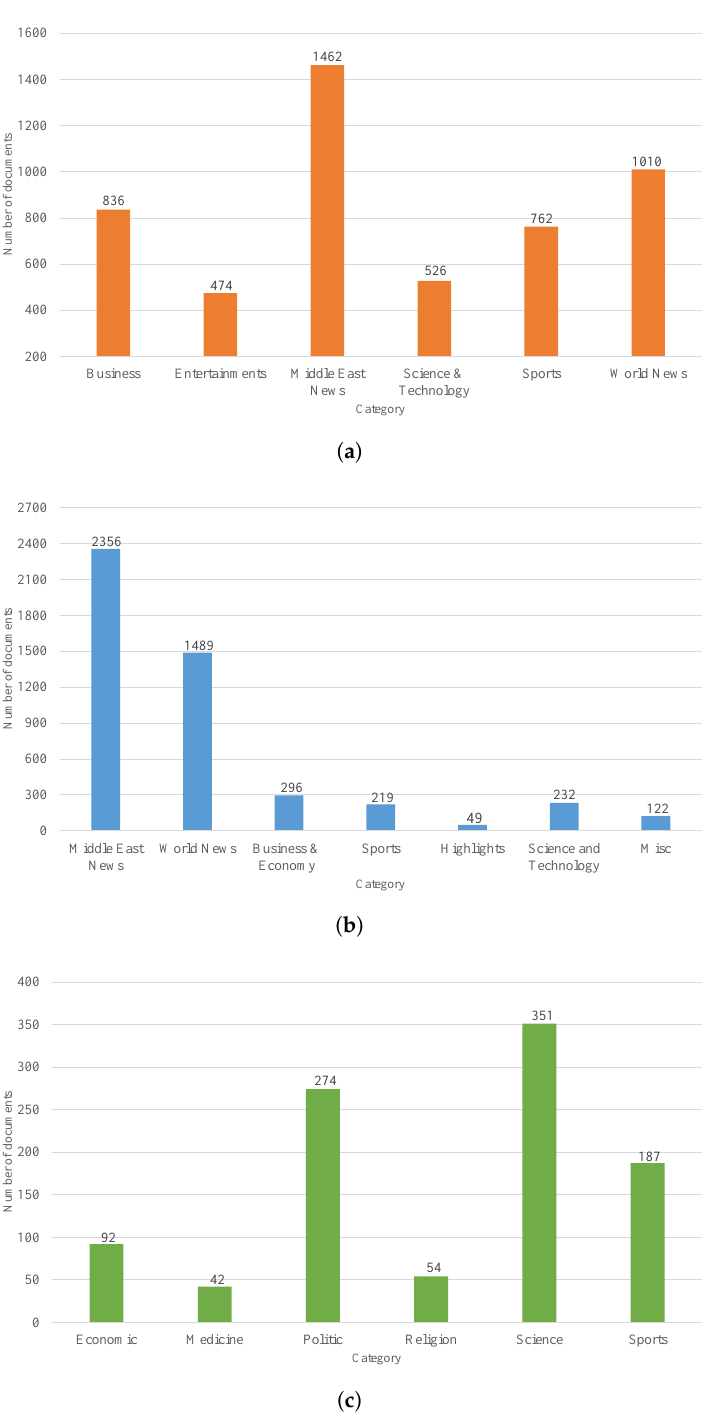
PSO uses various parameters during its configuration. During the experiments, the number of particles is set to 50, and the number of iterations is set to 100. “ c 1 ” and “ c 2 ”, which are PSO acceleration coefficient values, are set to 2. Moreover, classifiers’ training parameters were configured according to the default parameters, and as listed in Table